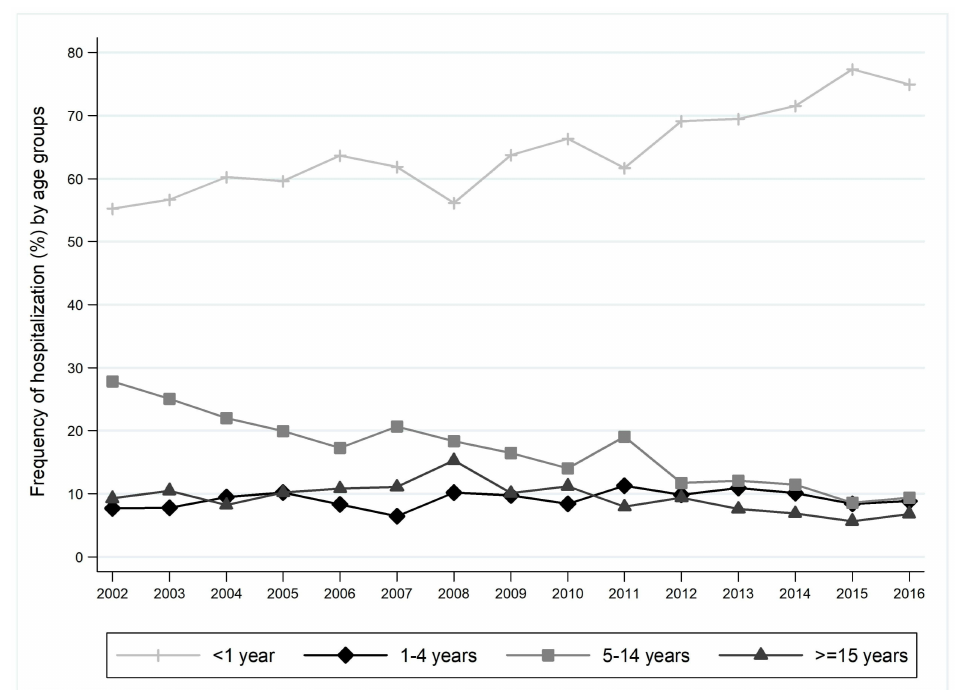
Figure 1. Frequency of hospitalization for pertussis in Italy stratified by age groups (2002–2016 time-frame). Trend test. < 1 year: β coe ffi cient = 1.37, p < 0.001; 1–4 years: β coe ffi cient = 0.11; p = 0.178;